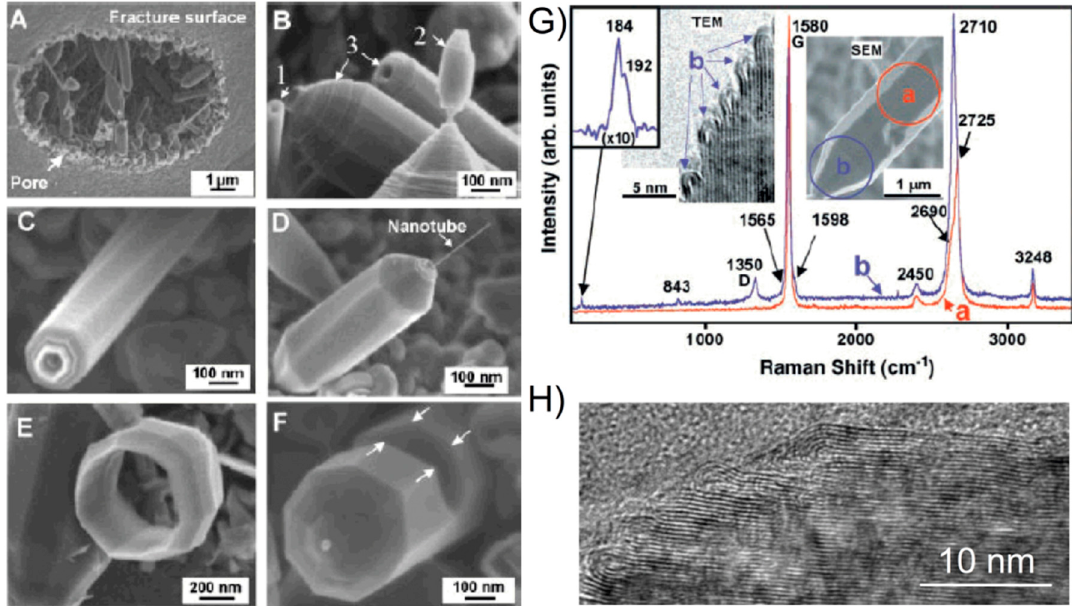
Figure 18. ( A – F ) Scanning electron micrographs of graphite polyhedral crystals found in pores of Toyo Tanso GL-200 glassy carbon. ( G ) Raman spectra of a polyhedral nanotube found in Toyo Tanso glassy carbon with insets of its SEM and TEM images. Reproduced with permission from Gogotsi et al. [82]. Copyright The American Association for the Advancement of Science, 2000. ( H ) TEM image of a polyhedral nanotube found in polyfurfuryl alcohol-derived glassy carbon, recorded with the S/TEM Titan 80–300 microscope at accelerating voltage of 300